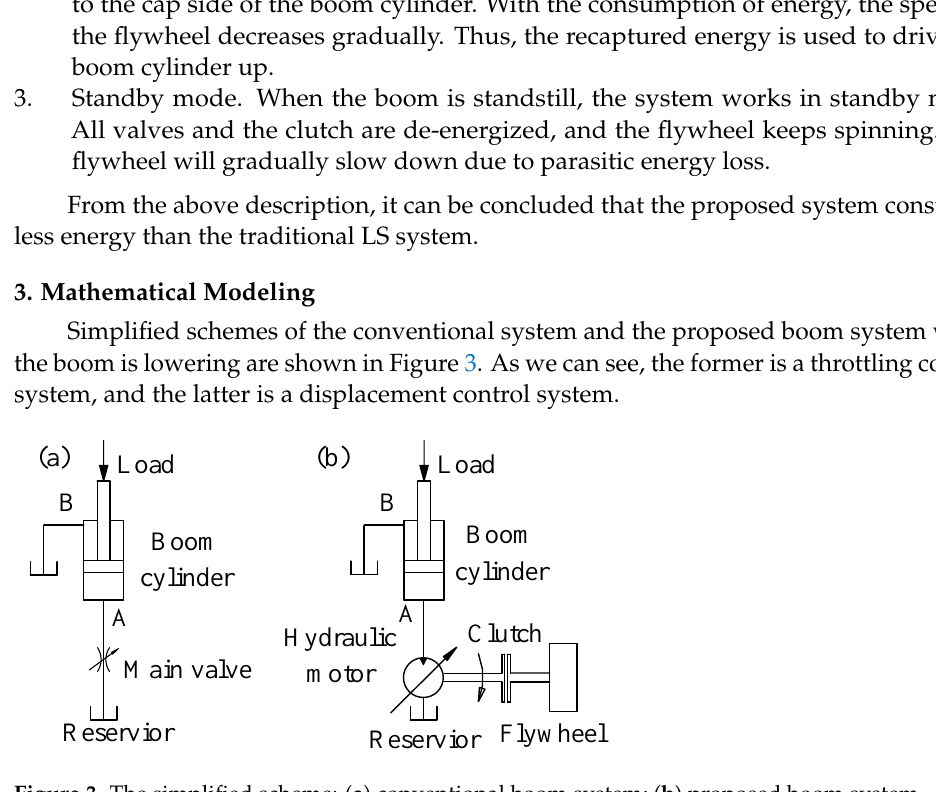
Figure 3. The simplified scheme: ( a ) conventional boom system; ( b ) proposed boom system.